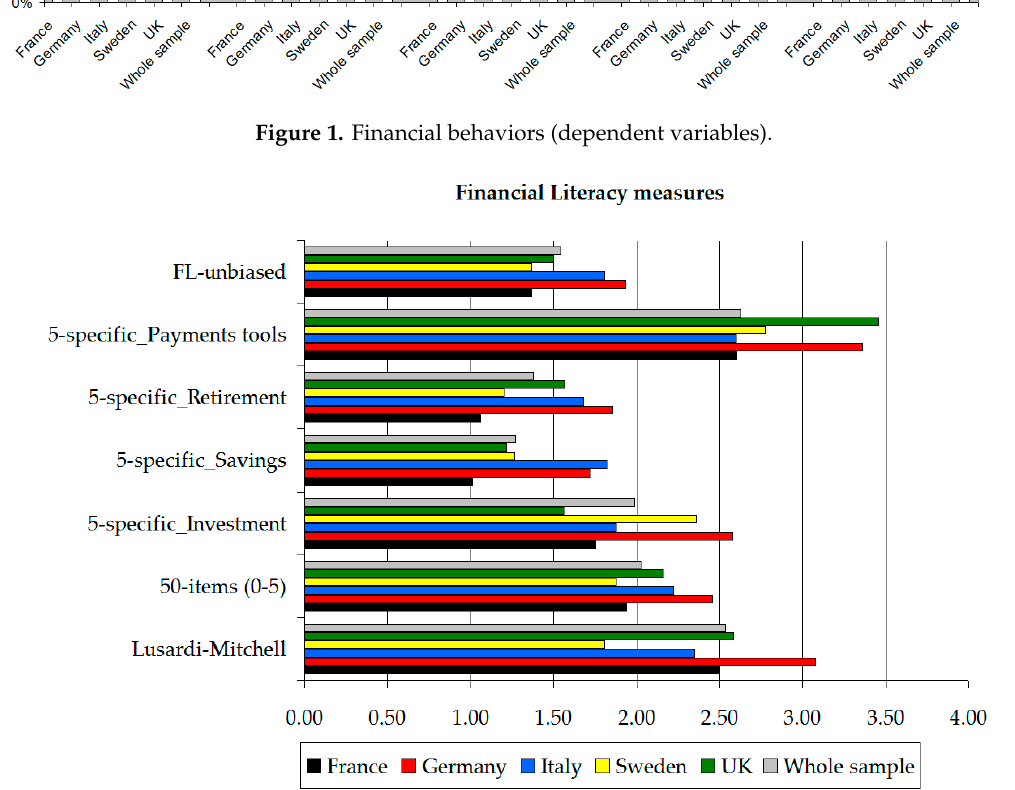
Figure 2. Financial literacy measures (scale 0–5).